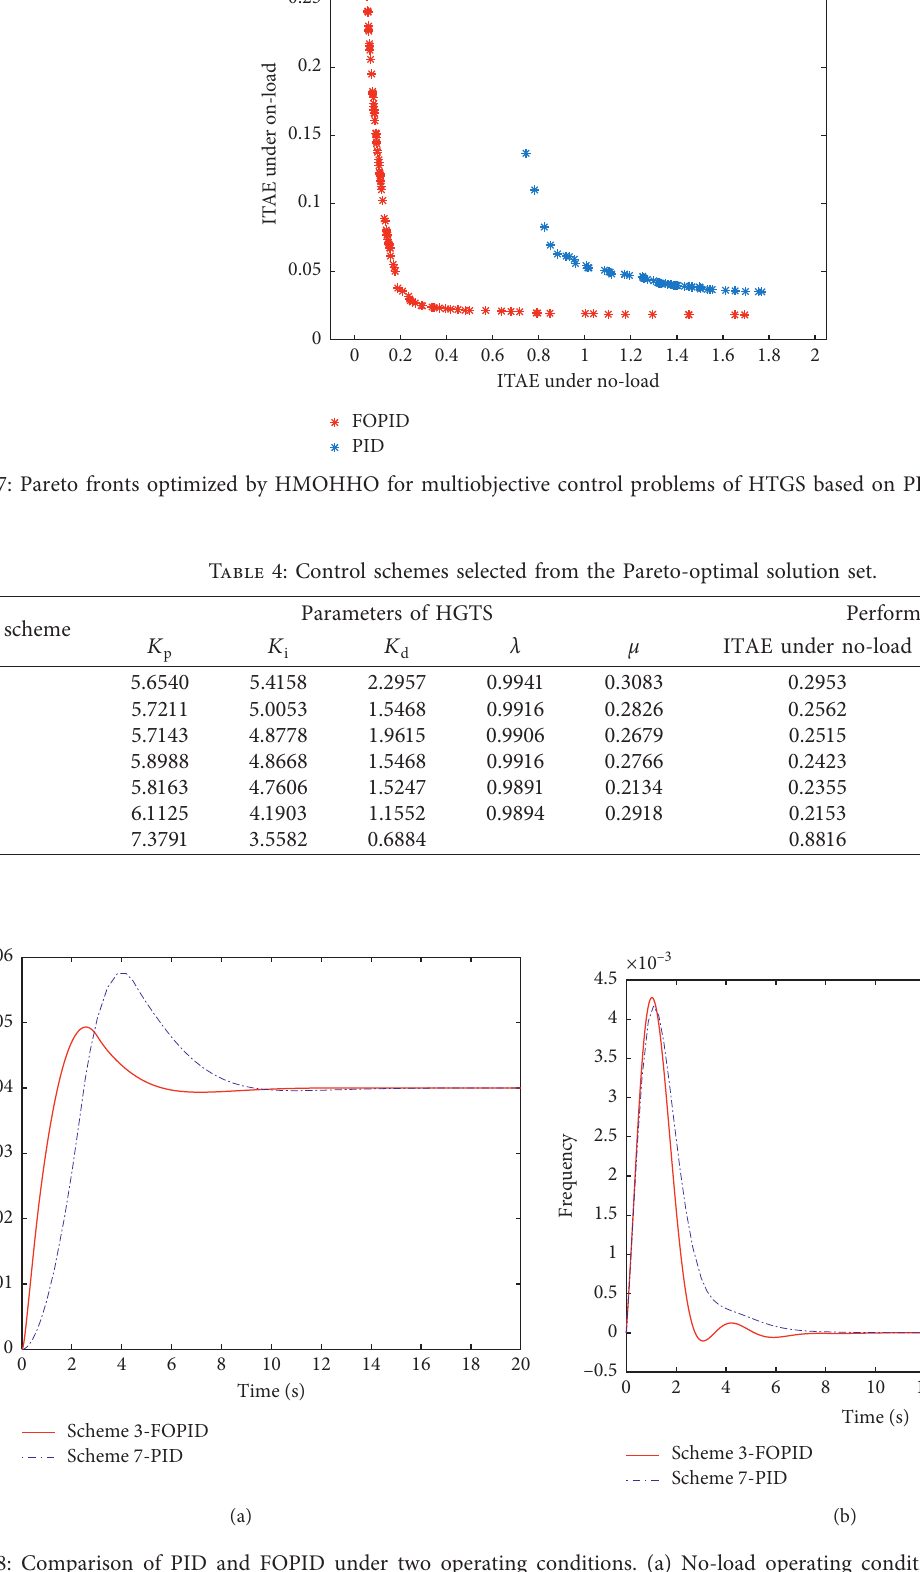
Figure 8: Comparison of PID and FOPID under two operating conditions. (a) No-load operating condition; (b) on-load operating condition.